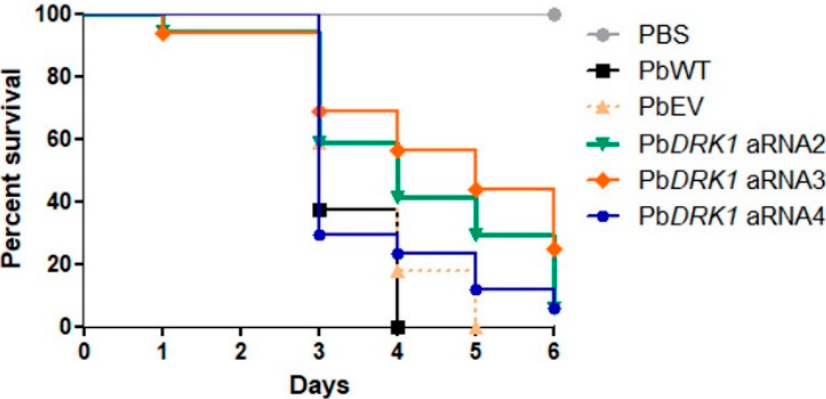
Figure 8. Knockdown of DRK1 expression confers a less virulent profile to P. brasiliensis. Survival curve of G. mellonella infected with 5 × 10 6 cells of the strains, PbWT, PbEV, Pb DRK1 aRNA2, Pb DRK1 aRNA3, and Pb DRK1 aRNA4, incubated at 37 °C, and the death monitored daily. PbWT vs. PbDRK1 aRNA2, p = 0.0226; PbWT vs. Pb DRK1 aRNA3, p = 0.0025; PbEV vs. PbDRK1 aRNA3, p = 0.0185; at the end of experiment ( n = 17 larvae).